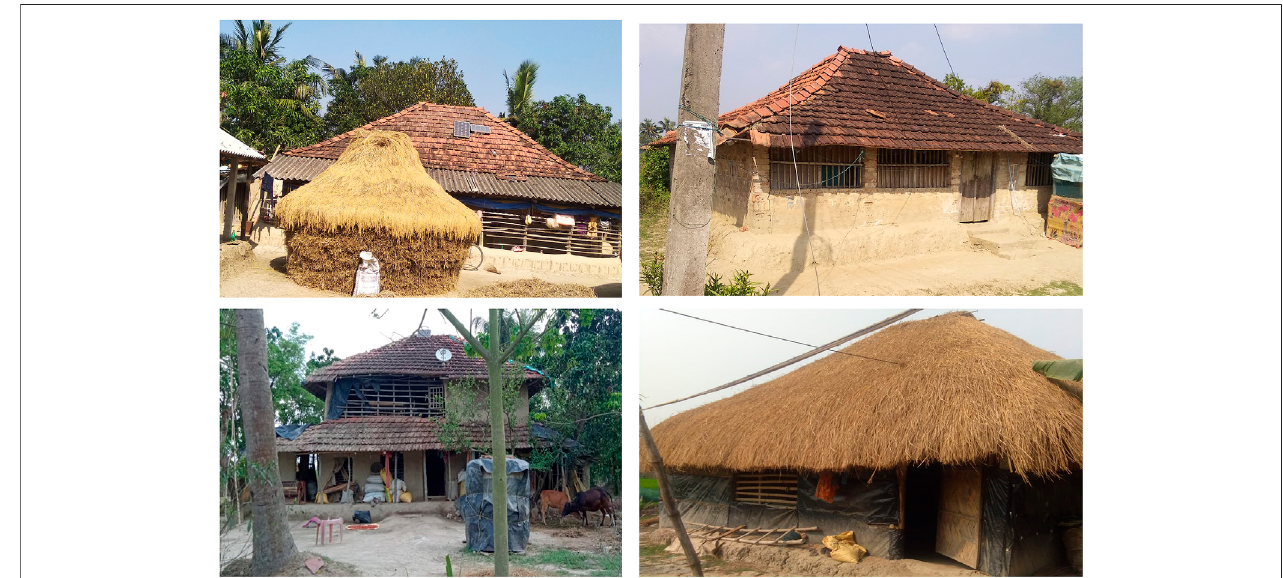
FIGURE 3 | Dwelling patterns (outer structure) of remote rural, rural, and semi-urban areas.